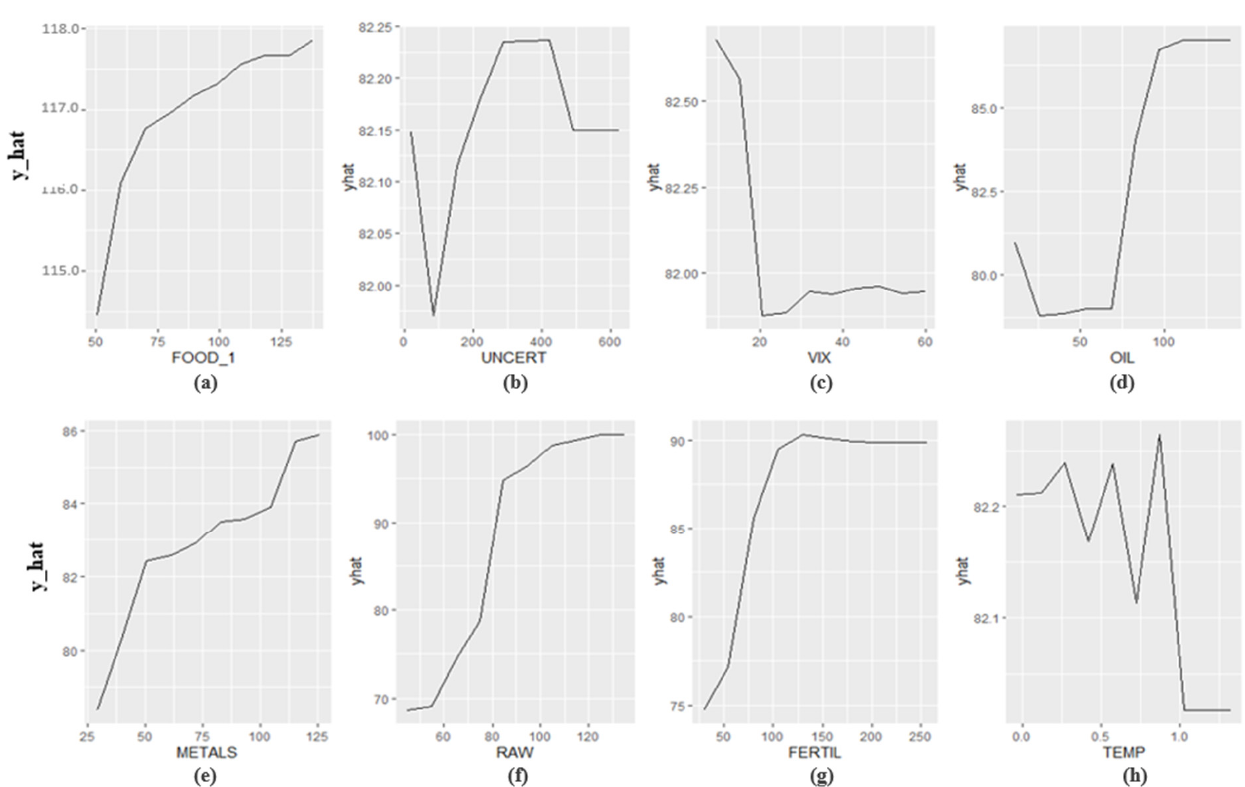
Figure 4. Critical thresholds of the independent variables. ( a ) FOOD_1, ( b ) UNCERT, ( c ) VIX, ( d ) OIL, ( e ) METALS, ( f ) RAW, ( g ) FERTIL and ( h ) TEMP.